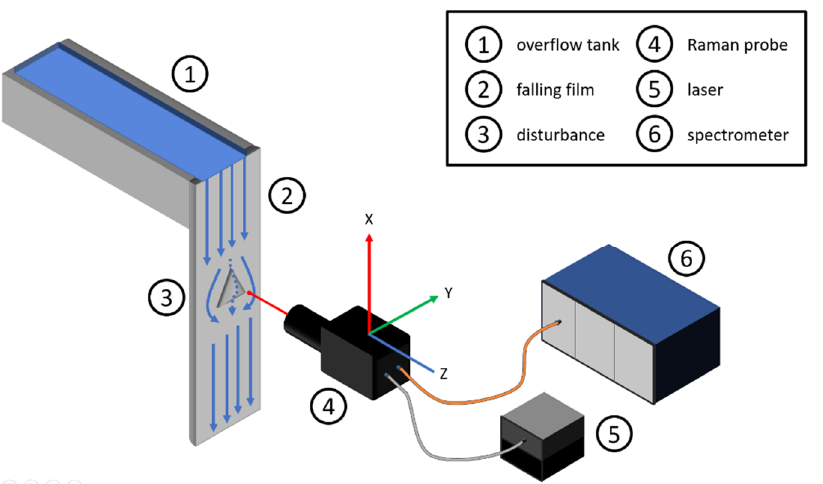
Figure 1. Schematic diagram of the experimental plant containing the overflow tank (1), the falling film itself (2), the disturbance as well as the Raman probe (4), the laser as excitation source (5), and the Raman spectrometer.